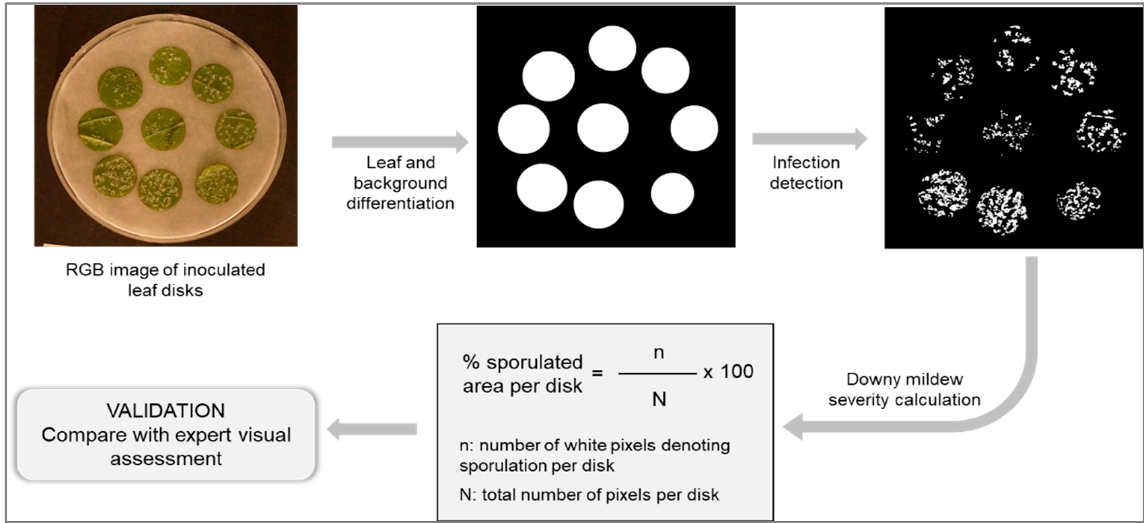
Figure 2. Flowchart of the use of computer vision for assessing downy mildew severity in grapevine leaves under laboratory conditions.